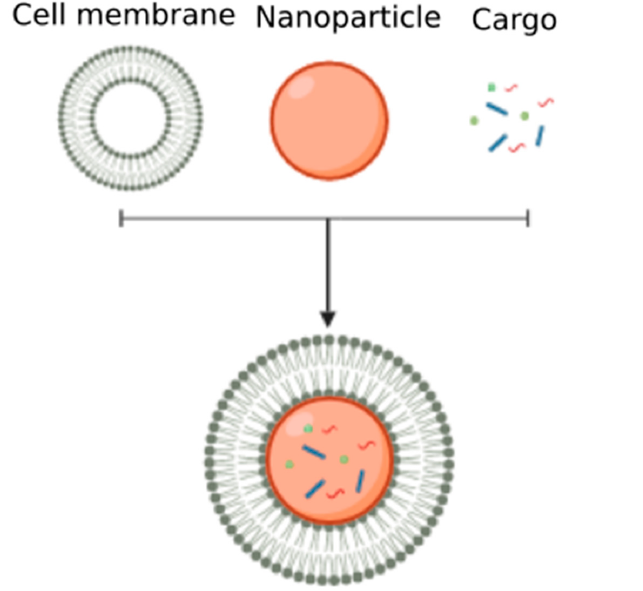
Figure 4. Biomimetic Polymer Nanoparticles. Cell plasma membrane that has been isolated and purified can be mixed with a polymer-based nanoparticle to create a cell-membrane-cloaked particle. Di ff erent types of cargo can be loaded within the polymer